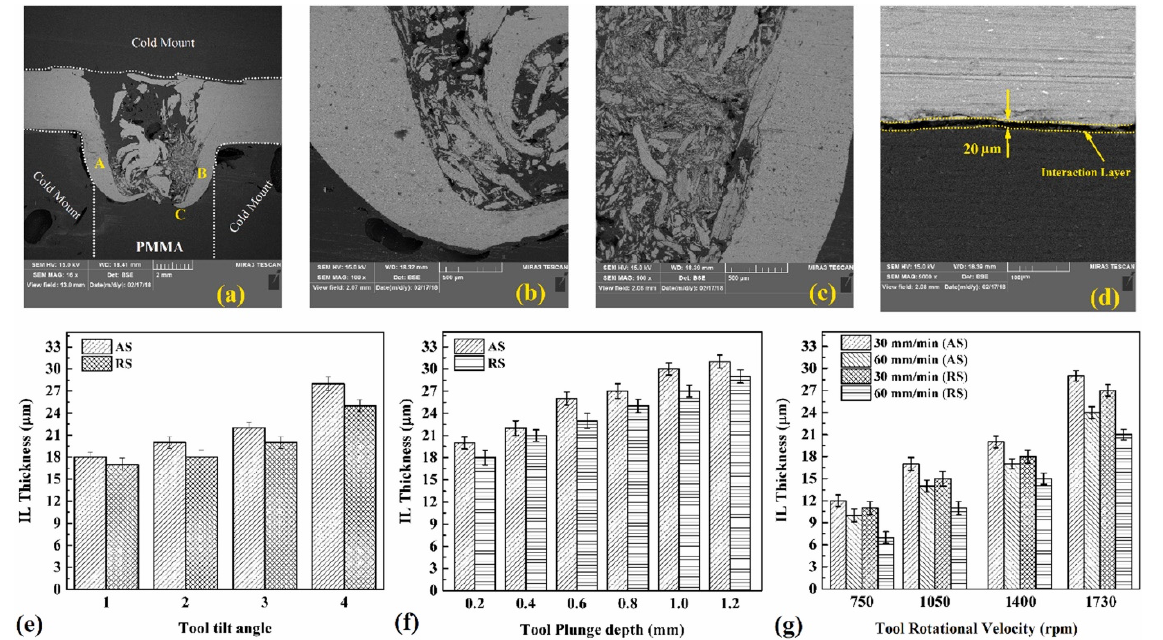
Figure 4. Magnification SEM image of the ( a ) the showing side, ( b ) the retreating side (Label A), ( c ) the advancing side (Label B), and ( d ) the interaction layer (Label C). Effects of the ( e ) tool tilt angle, ( f ) tool plunge depth, and (g) tool rotational velocity on the thickness of the interaction layer. Reprinted with permission from Ref. [74]. 2019, H.A. Derazkola, A. Simchi.